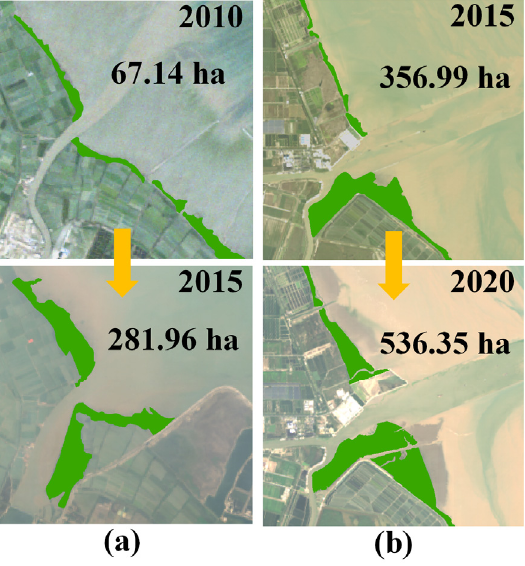
Figure 14. Landsat R-G-B images. Green is S. alterniflora . ( a ) The distribution area of S. alterniflora in the estuary of Linhong River from 2010 to 2015. ( b ) The distribution area of S. alterniflora in the estuary of Sheyang River from 2015 to 2020.